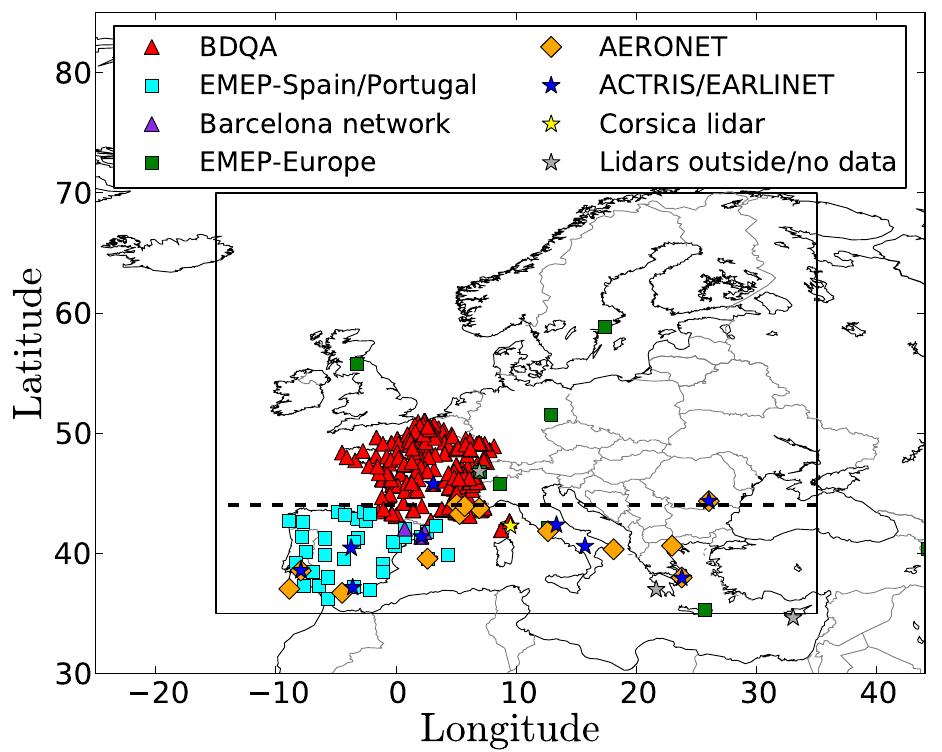
Figure 1. Locations of the different measurement sites used in this paper (see Tables 1 and 3 for the number of stations used in the different networks). The rectangular area delimited by the black box shows our modelling domain. The red triangles indicate the locations of the stations of the French air quality network (BDQA). The cyan squares indicate the locations of the stations of the EMEP-Spain/Portugal network. The violet triangles indicate the locations of the stations around Barcelona. The green squares indicate the locations of the EMEP- Europe stations. The orange diamonds indicate the locations of the AERONET stations. The dark blue/grey star markers indicate the locations of ACTRIS/EARLINET stations. The grey star markers indicate lidar stations without data between 9 and 12 July or outside of the forecast domain. The yellow star marker indicates the location of the Corsica lidar station. The dashed line shows the latitude of 44 ◦ N which is used to split the French stations in Sect.